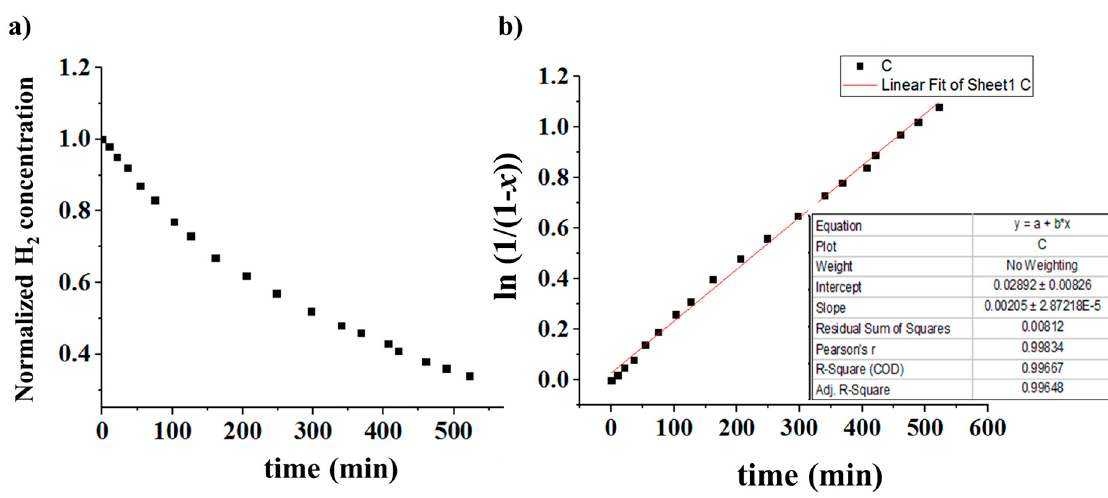
Figure 5. ( a ) Plot of normalized H 2 concentration against time at 273 K. ( b ) Plot of ln(1/(1- x )) with time and linear data fitting.